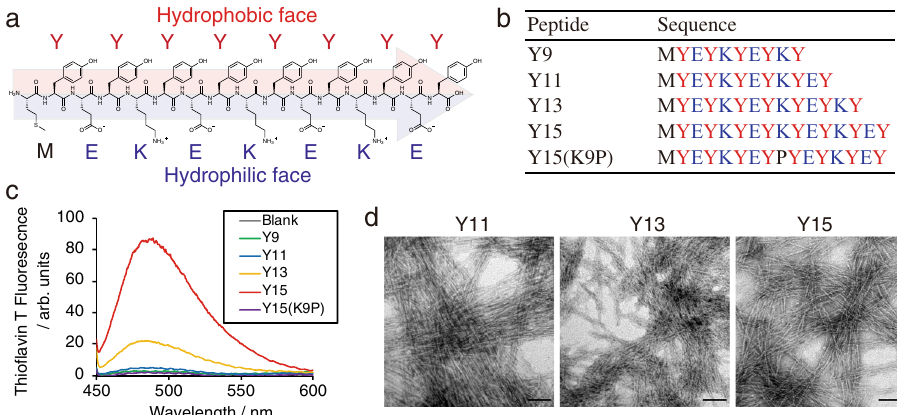
Fig. 1 Self-assembly of Yn de novo peptides. a Chemical structure of Y15 peptide. b A list of tested Yn peptides that differ in length and the negative control. c Thio fl avin T fl uorescence assay of Yn peptide assembly. Yn peptides (10 µ M) in PBS were incubated for 24 h at 37 °C and then 25 µ M thio fl avin T dye was added. The fl uorescence spectra were measured by F-7000 (Hitachi) with FL Solution. Source data are provided as a Source data fi le. d Negative- stained TEM observations of Y11, Y13, and Y15. Peptides (100 µ M) in PBS were incubated for 22 h at 37 °C. The mixture was attached to grids and negatively stained by nano-W. Scale bar, 100 nm.